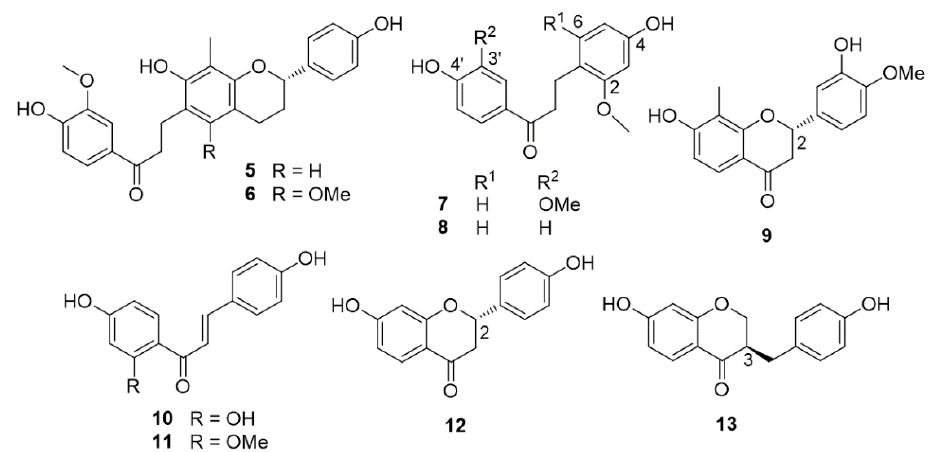
Figure 3. Chemical structures of compounds 5 – 13 isolated from D. cambodiana.